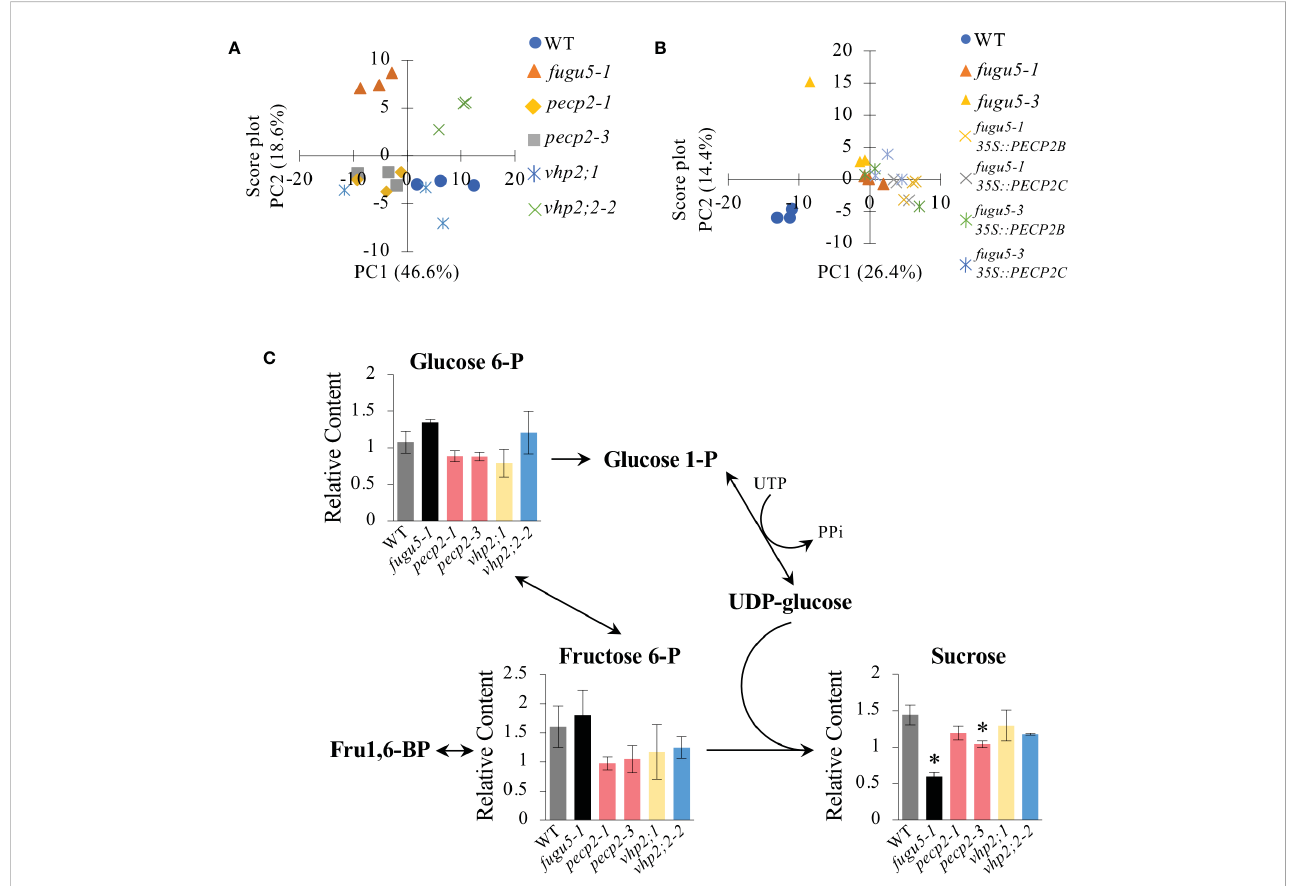
FIGURE 8 Comparative metabolomic analysis of etiolated seedlings. Metabolomic analysis of etiolated seedlings was performed by GC-MS/MS ( n = 3 biological replicates; 100 etiolated seedlings per sample). Etiolated seedlings were grown on MS-only medium in the dark for 3 DAI. (A) Principal Component Analysis (PCA) score plot of the WT, fugu5-1 , pecp2-1 , vhp2;1 , vhp2;2-2 , vhp2;1 vhp2;2-2 and fugu5-1 vhp2;1 lines. (B) PCA score plot of the WT, fugu5- 1 , fugu5-3 , fugu5-1 35S::PECP2 and fugu5-3 35S::PECP2 transgenic lines. Color plots refer to the genotype in the legend. (C) Pathway analysis focusing on gluconeogenesis-related metabolites. Metabolite contents relative to the quality control sample are plotted on the corresponding pathway. Data are means ± SD ( n = 3 biological replicates; 100 etiolated seedlings per sample). Asterisks indicate mutants with signi fi cant differences as compared to the WT (Dunnett ’ s test at P < 0.05). DAI, days after induction of seed